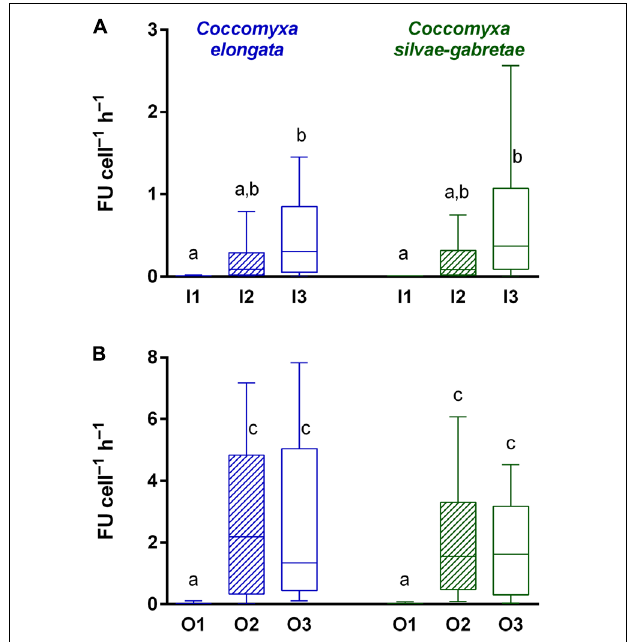
FIGURE 5 | Comparison of cell-specific phosphatase activity [in relative fluorescence units (FUs)] in the Coccomyxa cultures in P-replete (1) and P-depleted (2 and 3) media with either inorganic (I; top: A ) or organic (O; bottom: B ) P source. Box and whisker plots show medians (bar), 25 and 75% quartiles (box), and 10 and 90% percentiles (whiskers); note the different scales of y axes. Differences among treatments were tested using three-way ANOVA with a post hoc Tukey HSD test; lower case letters above the columns (a–c) indicate significant differences among treatments (see Table 3 for summary